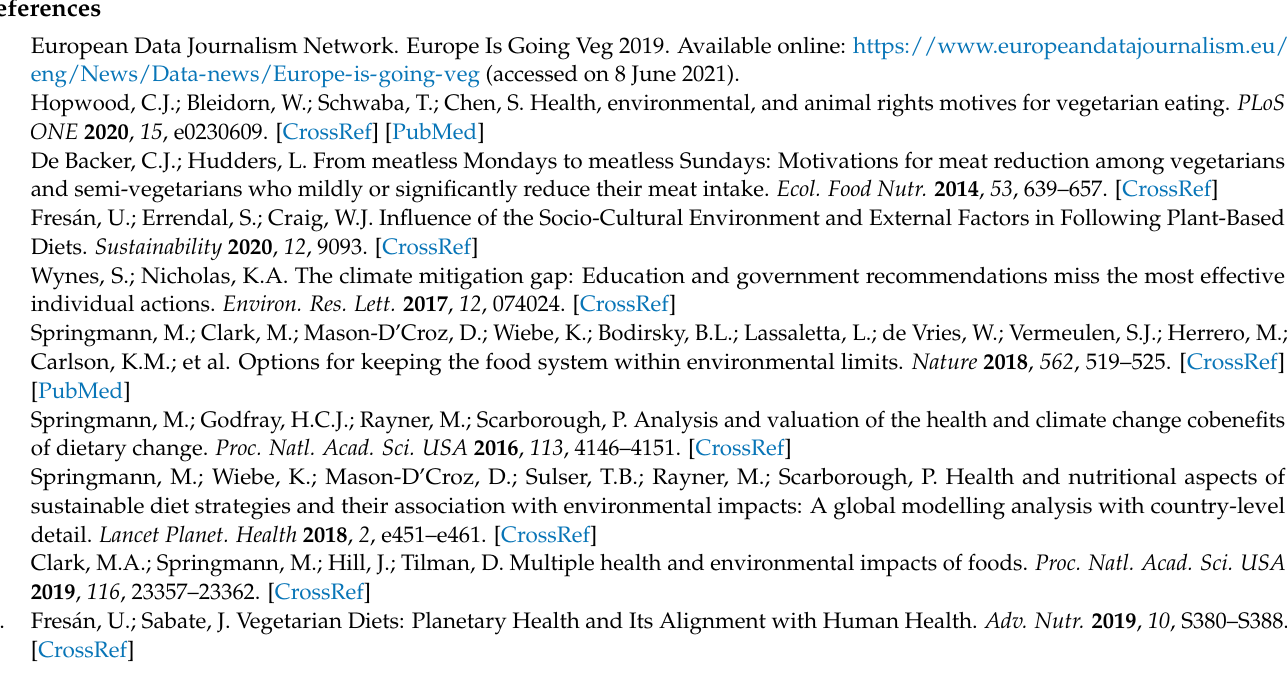
100 g of plant-based cheese alternatives, Table S2: Format, calories and nutritional content per 100 g of different types of dairy cheese, Table S3: Median (minimum-maximum) values of calories and nutritional content in coconut oil-based cheese alternatives per 100 g, by selling